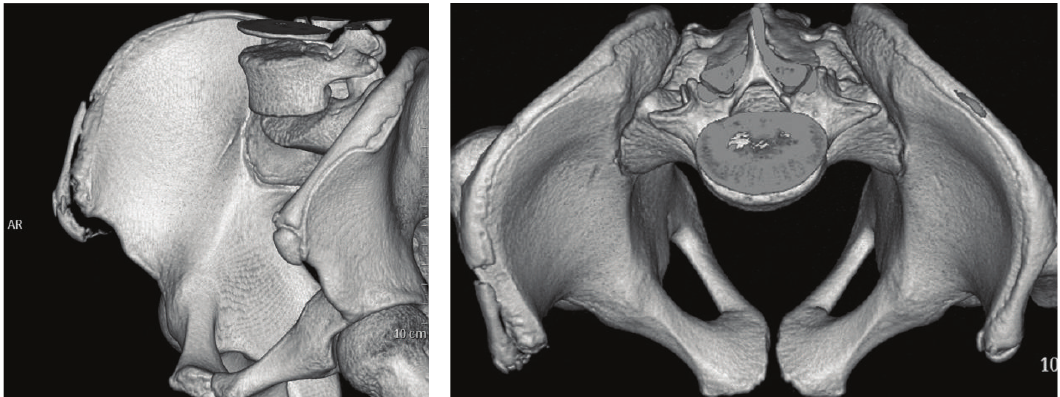
Figure 1: 3D CT scan. avulsion of a part of the iliac crest apophysis and the ASIS, downward and more outward.